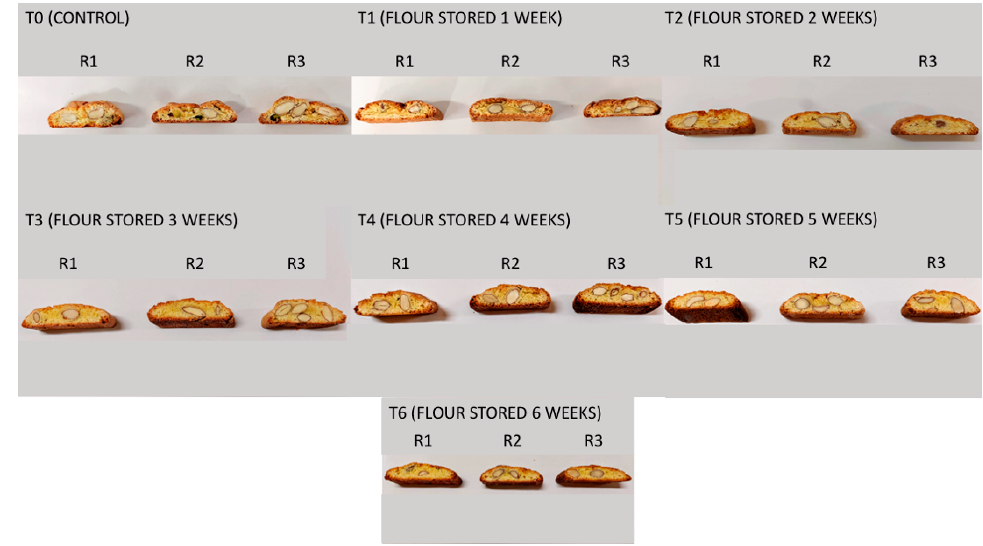
Figure 2. Biscuits (biscotto di Prato) obtained with the tested flours.